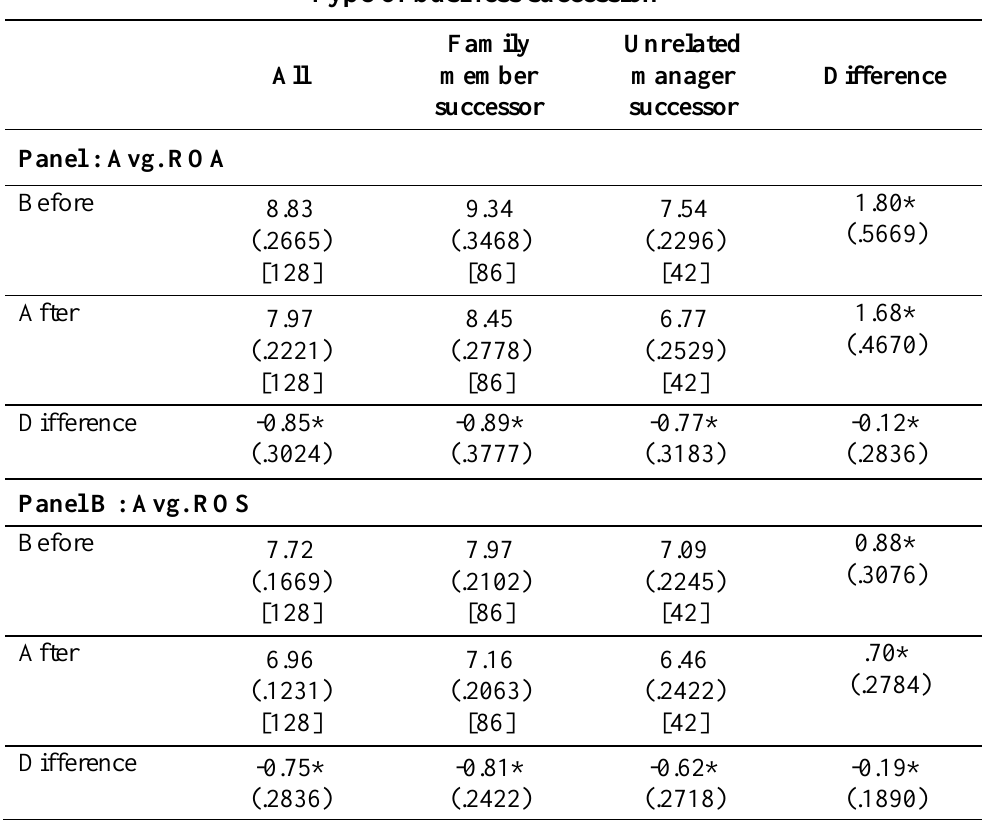
Table 4: Successions and changes in business performance